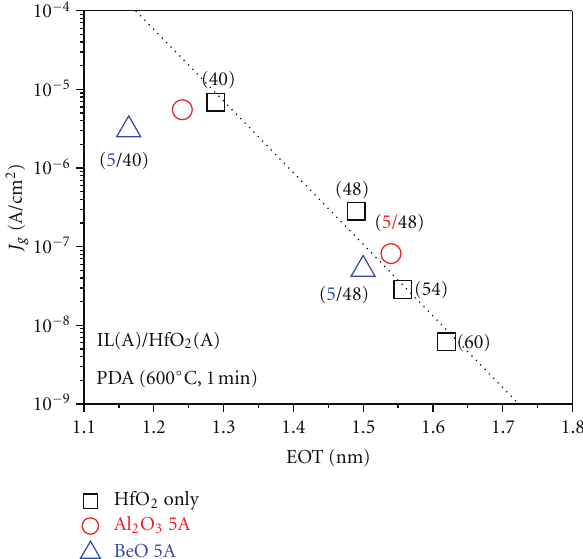
Figure 2: Gate leakage current versus EOT for SiO 2 /HfO 2 , Al 2 O 3 (IL)/HfO 2 , and BeO(IL)/HfO 2 gate stacks.